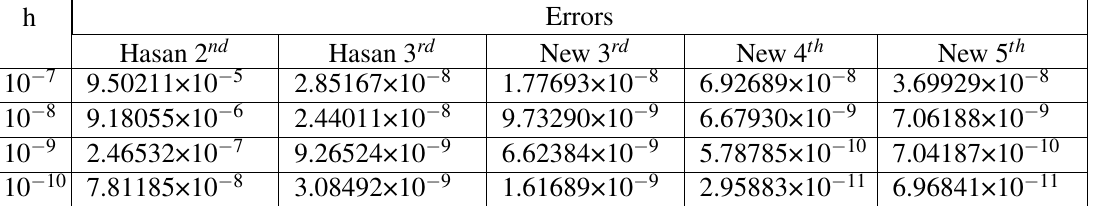
Table 4.1 (d): Absolute errors of the solution of Eq.(21) at x = 0 . 000001 by Hasan’s [13, 16] methods and new methods with Romberg scheme.